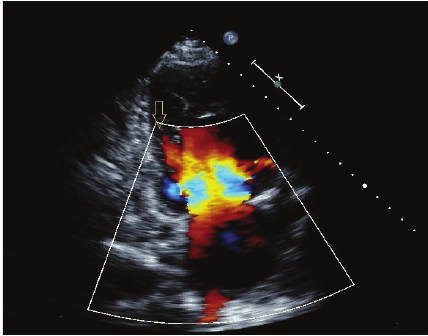
Figure 4: Color Doppler showing blood flow in sinusoids in the left